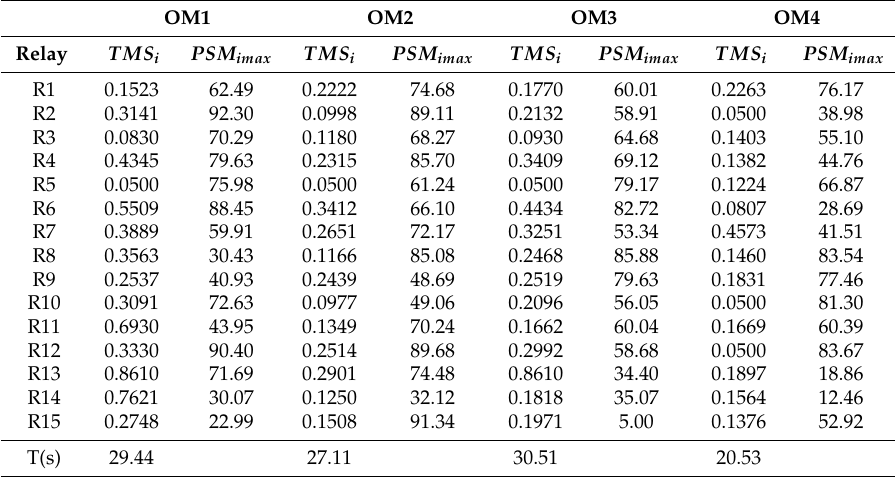
Table 14. Coordination parameters for a meshed topology under different OMs.